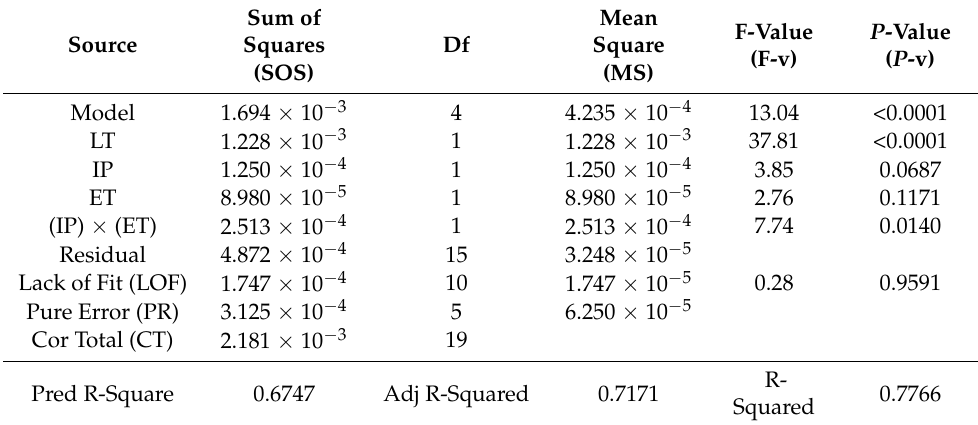
Table 6. Analysis of variance (ANOVA) for